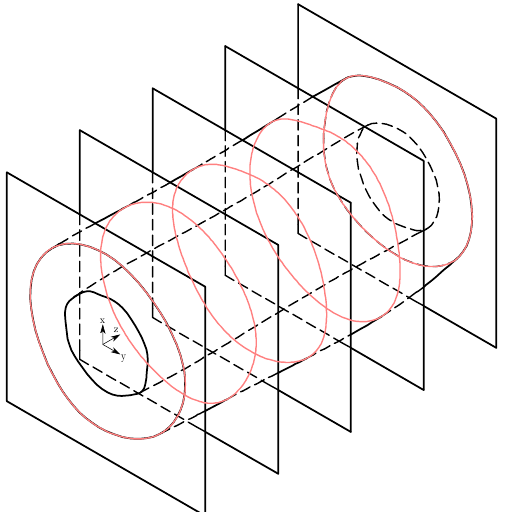
Figure 2. Schematic picture of the target function. The target function is defined as the mean RMS roundness error of equally spaced outer cross-sections of the